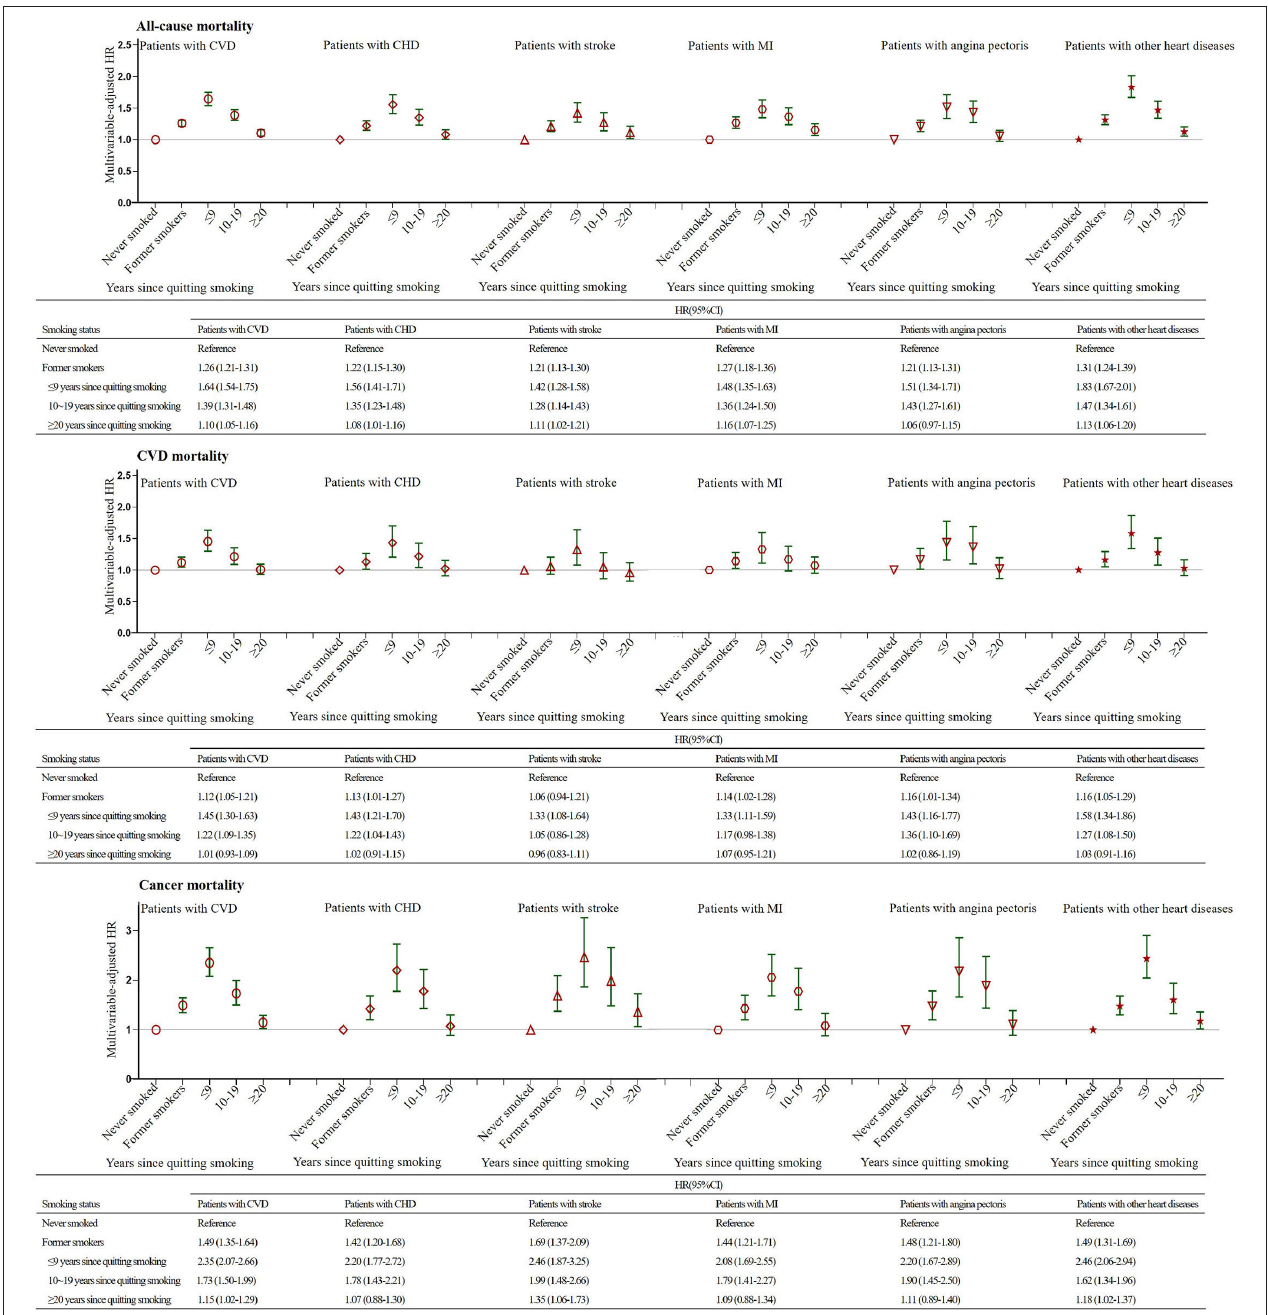
FIGURE 3 | Association of the Number of Years Since Smoking Cessation with All-cause, CVD and Cancer Mortality Stratified by the Presence of Cardiovascular Disease. The multivariable-adjusted model was adjusted for age, sex, race, education, income, body mass index, physical activity, alcohol intake, baseline hypertension, diabetes and cancer variables. CI, confidence interval; HR, hazard ratio; CVD, cardiovascular disease; CHD, coronary heart disease; MI, myocardial infarction.